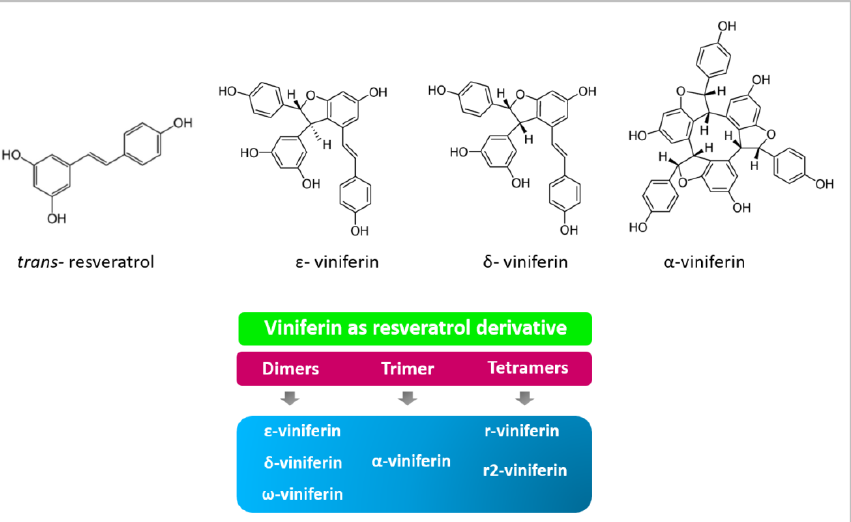
Figure 1. Resveratrol and viniferin chemical structures and viniferin forms classified according to the oligomer type of resveratrol [4].